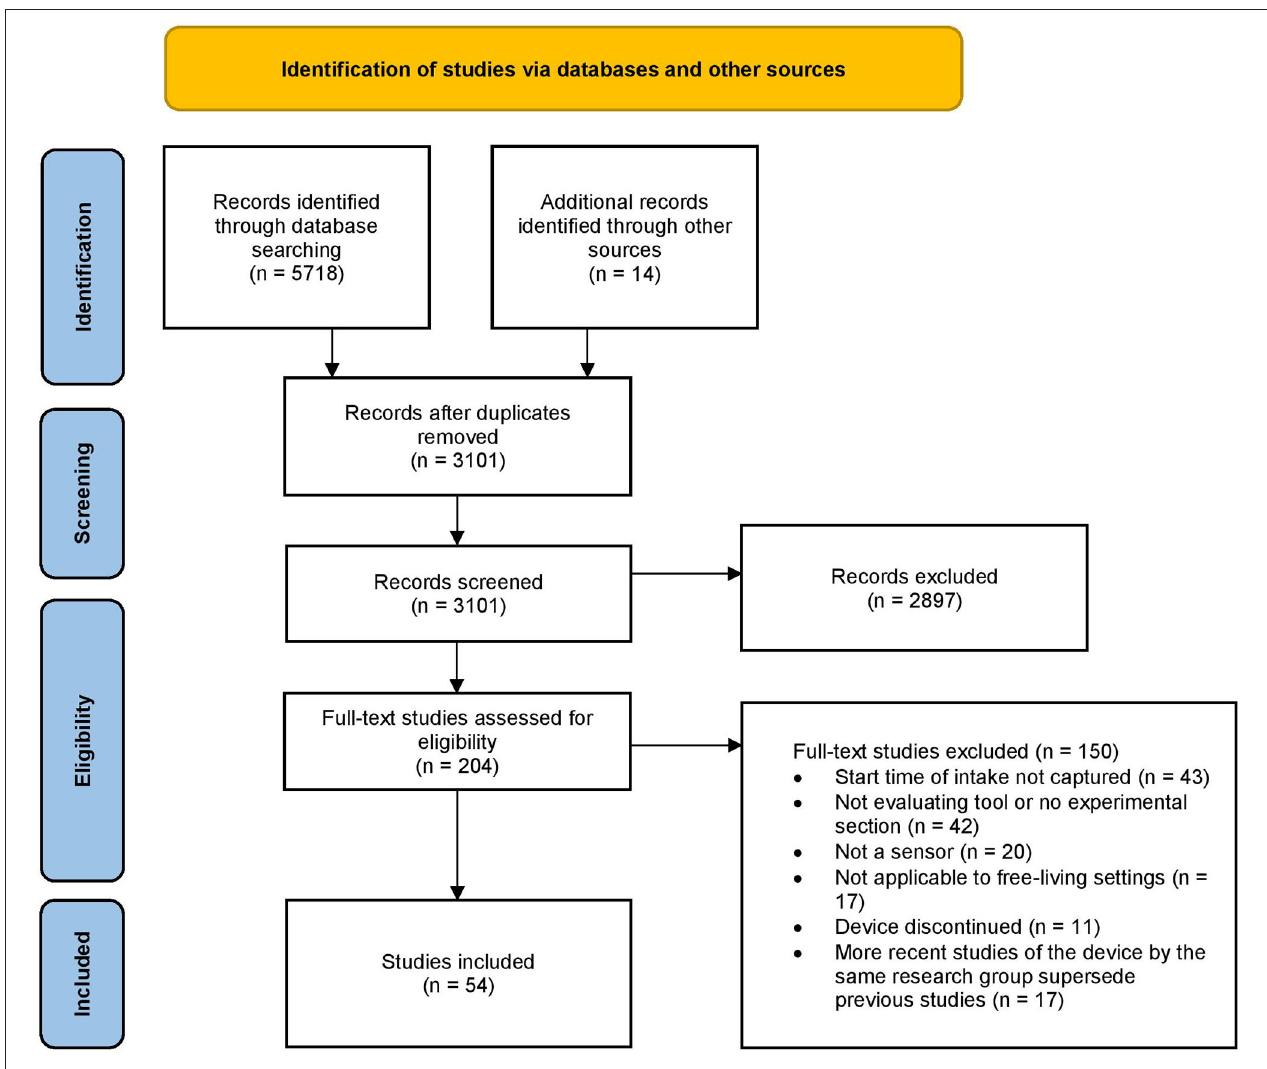
FIGURE 1 | Flow chart of included